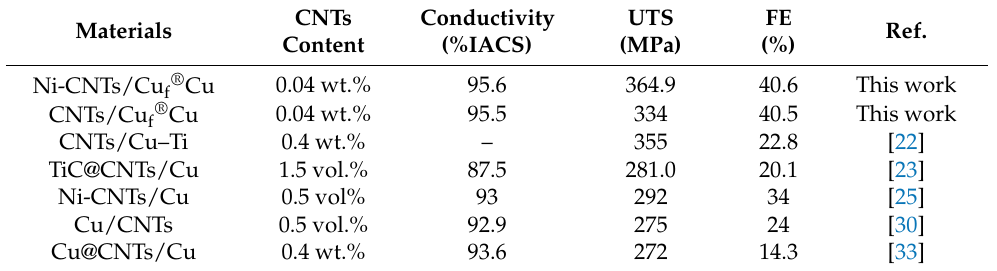
Table 2. Tensile properties and conductivities of composites prepared in this study and the